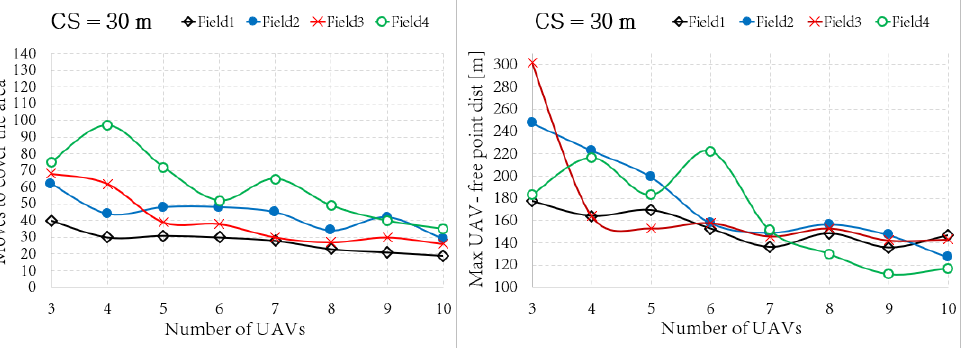
Figure 9. Results obtained after the fleet’s coverage optimization shown in Figure